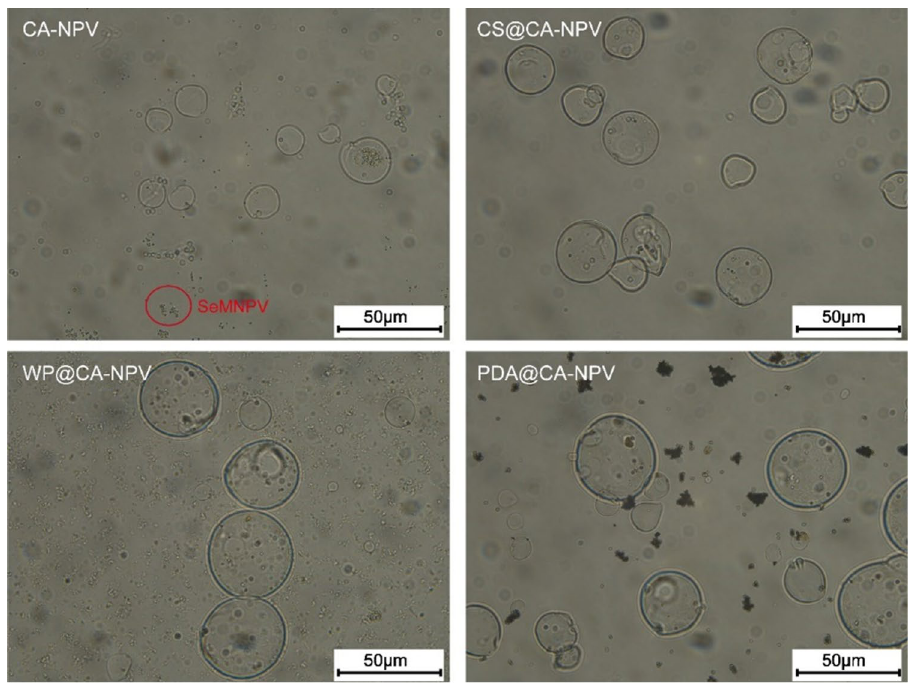
Figure 4. Surface morphology of microencapsulated preparations under light microscopy. A diluted sample suspension was deposited on a glass slide and observed using a fluorescence